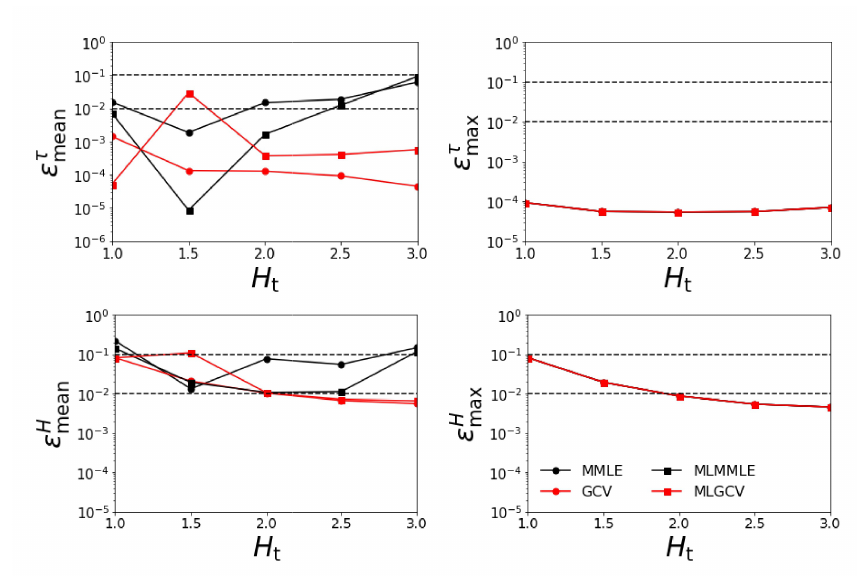
Figure 2. Relative errors ε τ mean , ε τ max , ε H mean , and ε H max versus H t for τ t = 1.0. All four aerosol models are